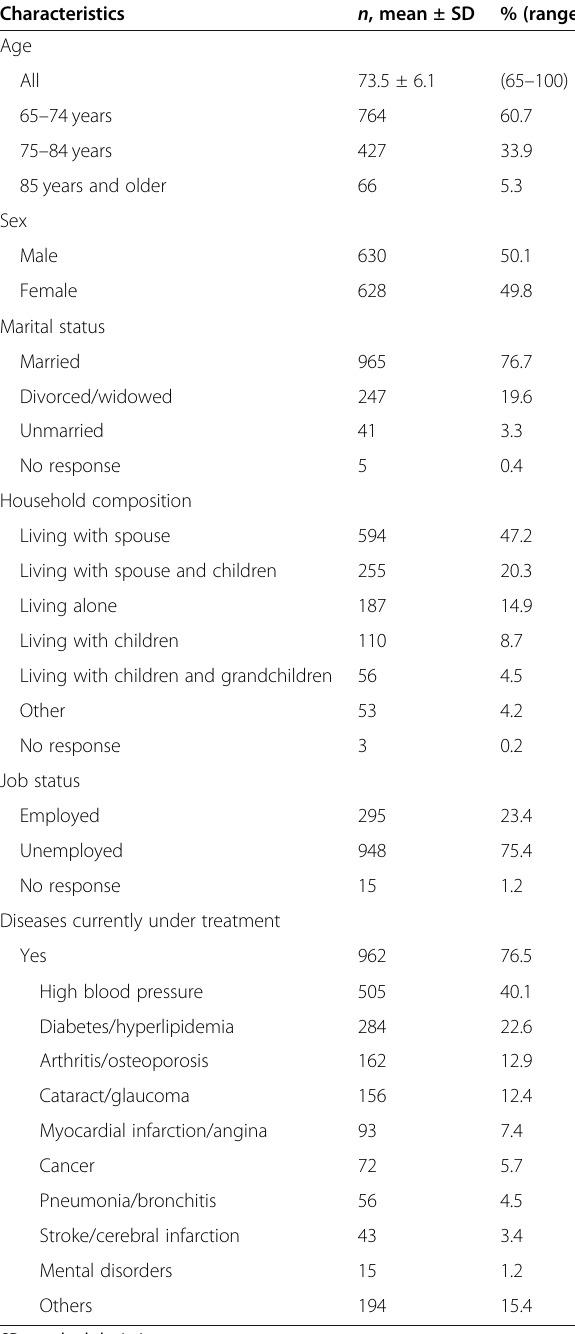
Table 1 Demographic characteristics of study participants ( n =